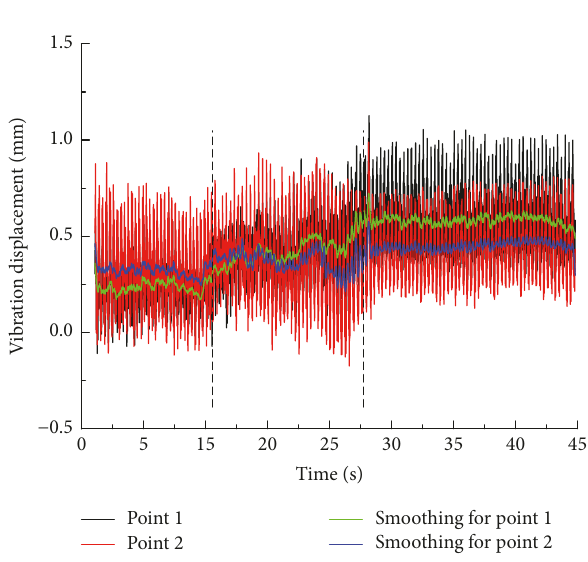
Figure 13: Vibration variation with time. the top nozzle playing good role in the rock breaking and debris carrying capacity. Therefore, the drilling speed of NDB was further improved. Meanwhile, vortex occurring more reduced the debris carrying capacity though the drilling performance of NFB was enhanced, and debris was